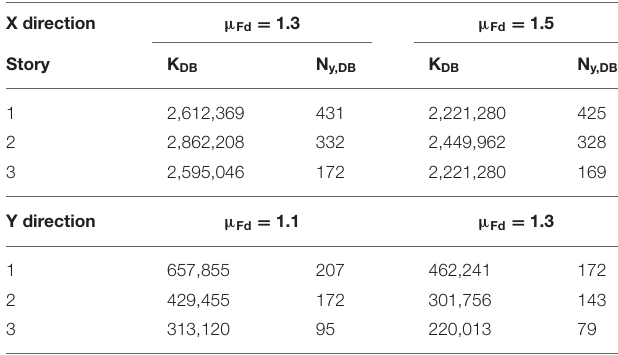
TABLE 3D | Stiffness (kN/m) and strength (kN) of the HYDBs (case B, CP limit state). X direction µ Fd = 1.3 µ Fd =